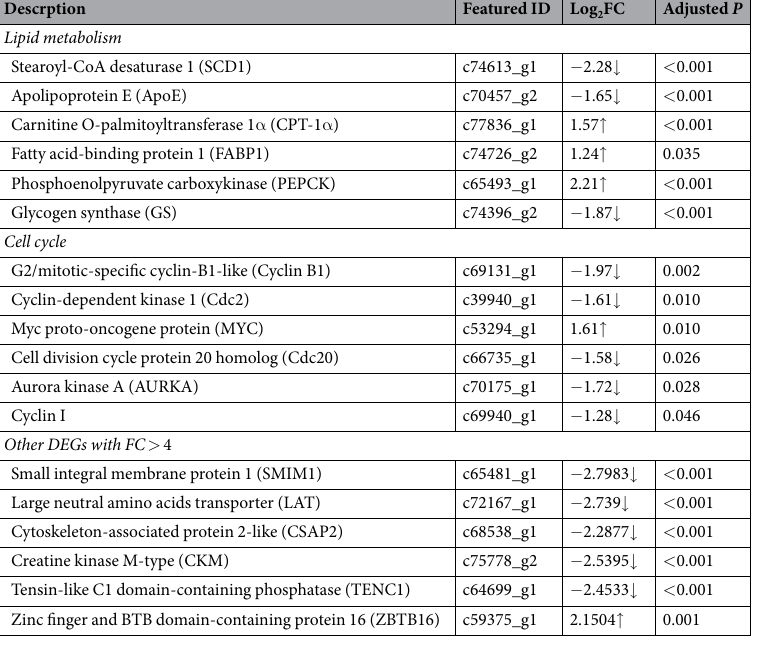
Table 1. Part of differentially ( P < 0.01) expressed genes between groups ARA-0.05 and ARA-0.37. “ ↑ ” and “ ↓ ” represents the up- and down-regulated genes in group ARA-0.37 respectively; FC, fold